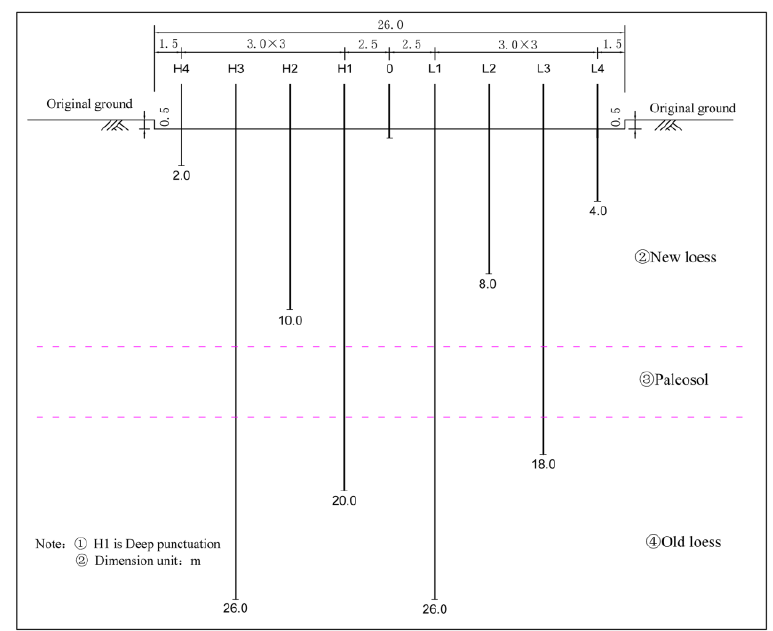
Figure 6. Punctuation elevation points.